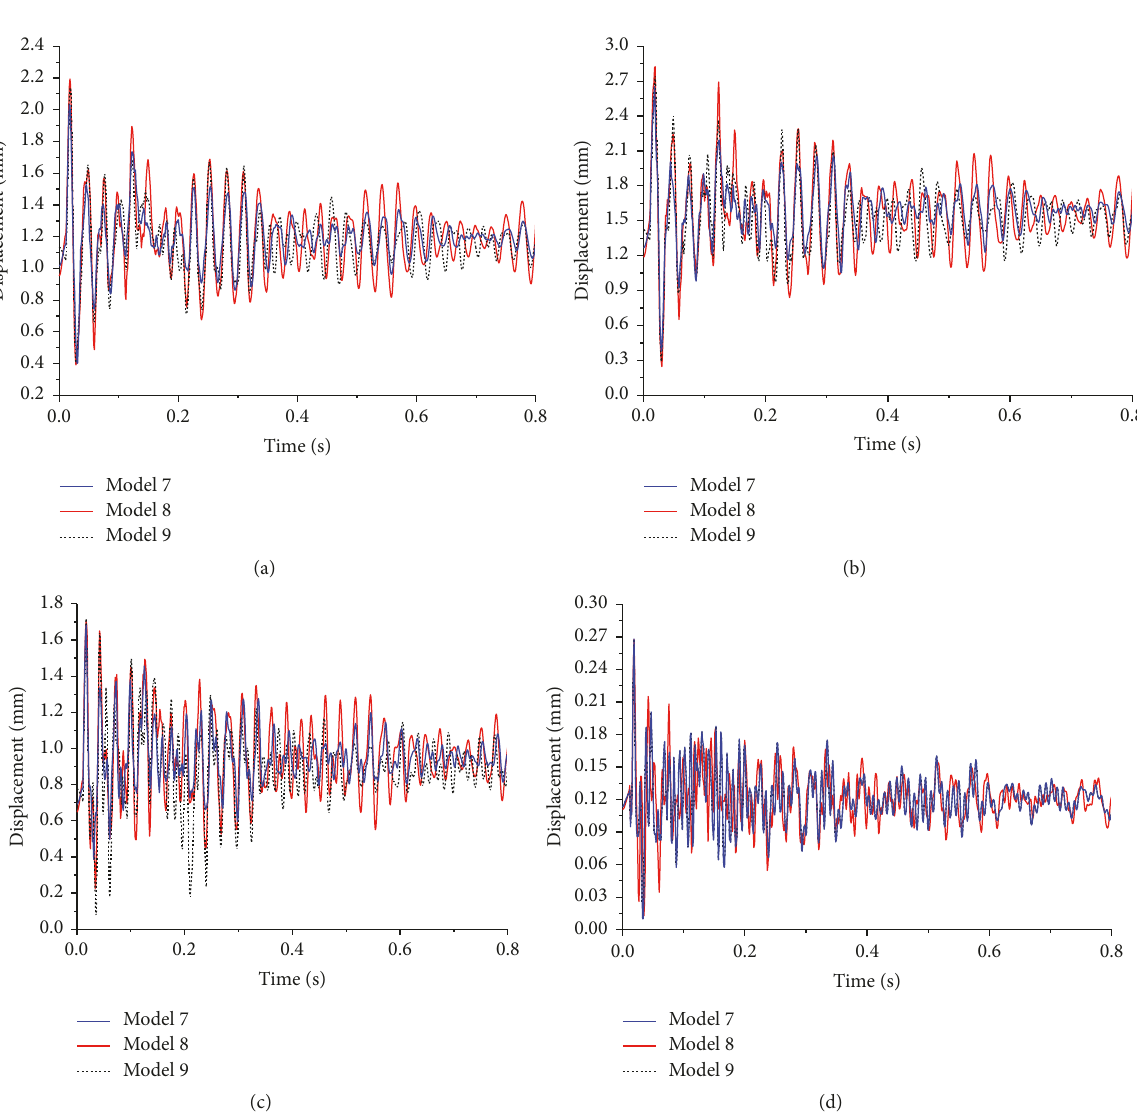
Figure 20: Node displacement-time curve: (a) node 1, (b) node 2, (c) node 3, and (d) node